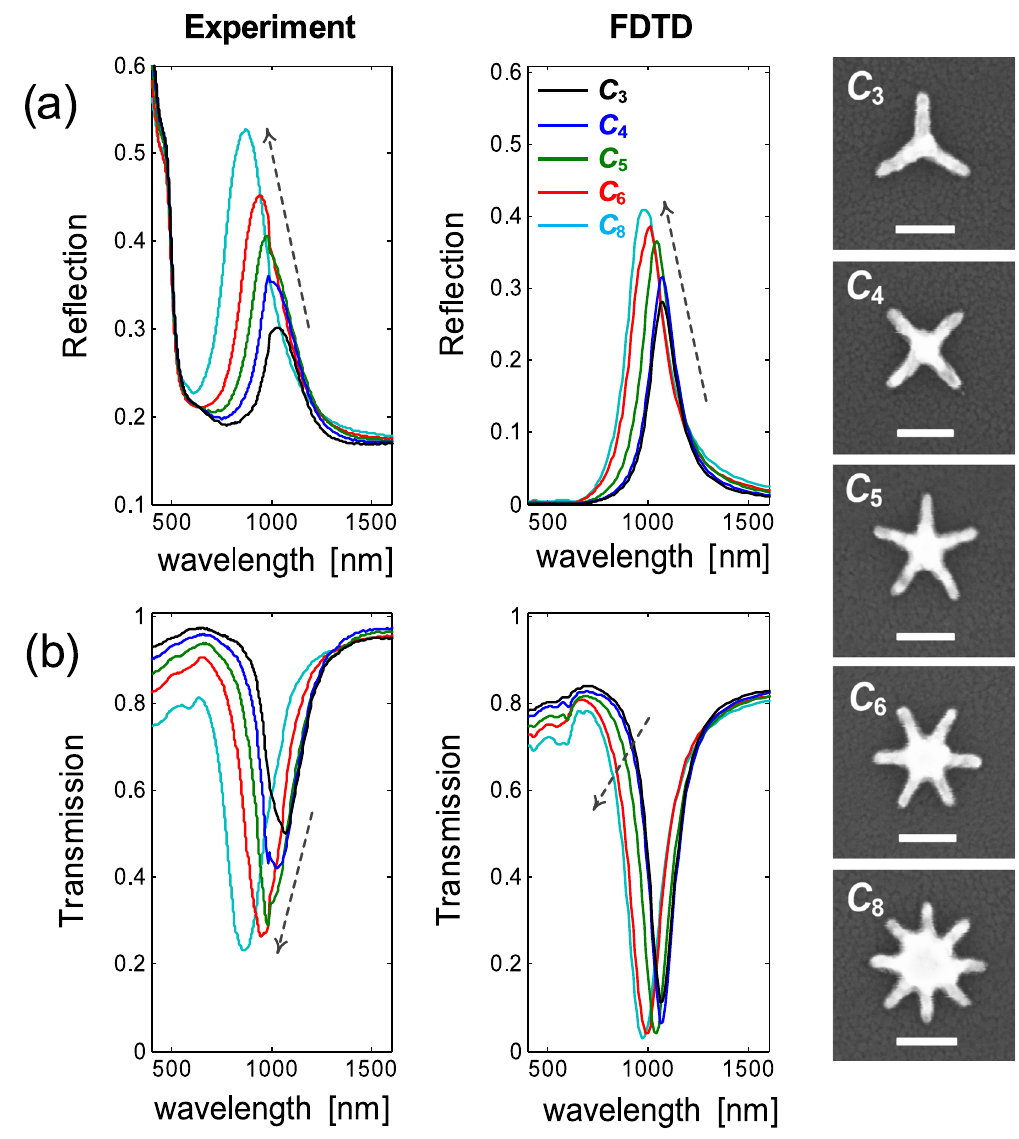
Figure 5. The role of internal rotational symmetry in improving optical response. The transmission and reflection contrasts increase progressively as the rotational symmetry is varied from n = 3 to n = 8. The arm length (s) and periodicity ( p ) of the C n structure is fixed to s = 100 nm and p = 300 nm, respectively. Due to fabrication non-idealities in denser structures, the effective arm length is shorter for C n with higher rotational symmetry. The scale bars in all the insets represent 100